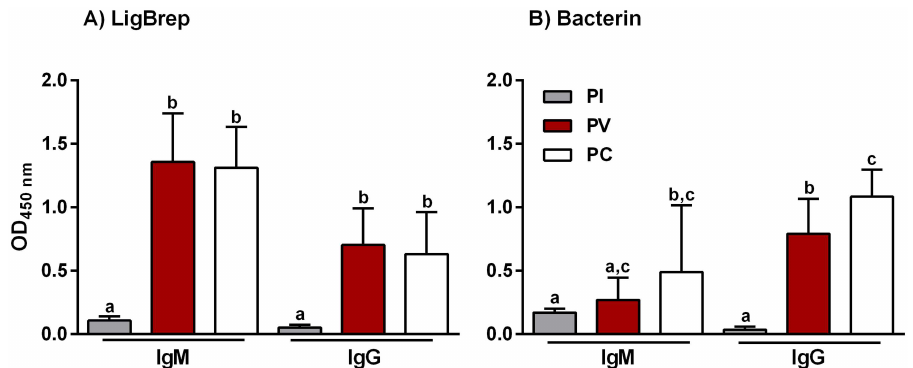
(PI), post-vaccination (PV) and post-challenge (PC) serum samples were collectedand characterized at a singleserum dilution(1:100) with anti-hamster IgM and IgG secondaryantibodies.The mean opticaldensity (OD 450 nm ) ± standard deviation(bars) from three independentexperiments are shown. Significance was determined by one-wayANOVA (Tukey multiplecomparison) analysis, the presenceof lower case letters, where different, indicatesa significantdifference ( P < 0.05) betweensamples.